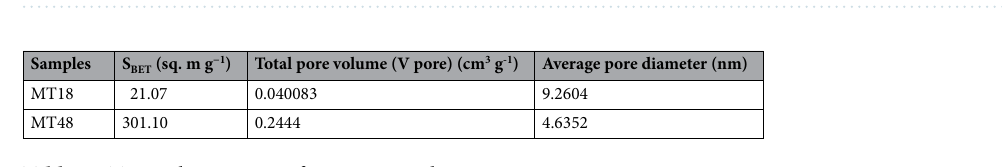
Table 2. Textural properties of MIL-125